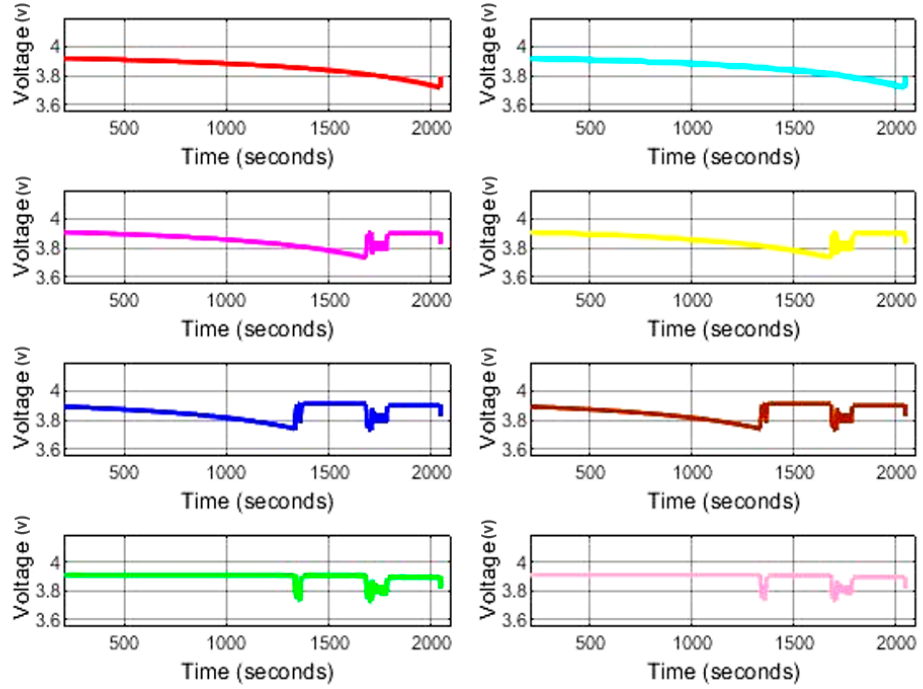
Figure 16. Voltage waveform in steady state for passive cell balancing—Voltage (volts) vs. time (s).